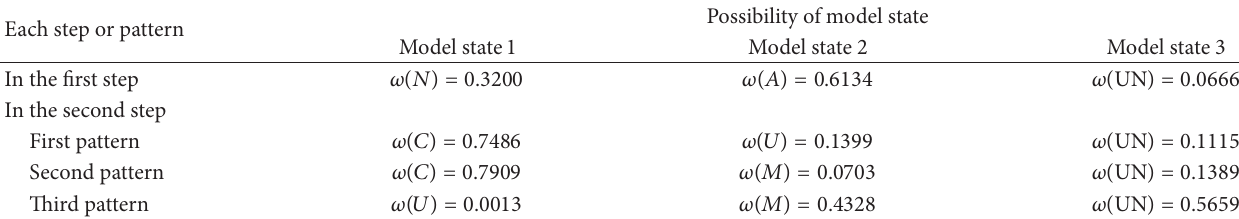
Table 5: The second diagnostic possibilities using the sequential diagnosis proposed.